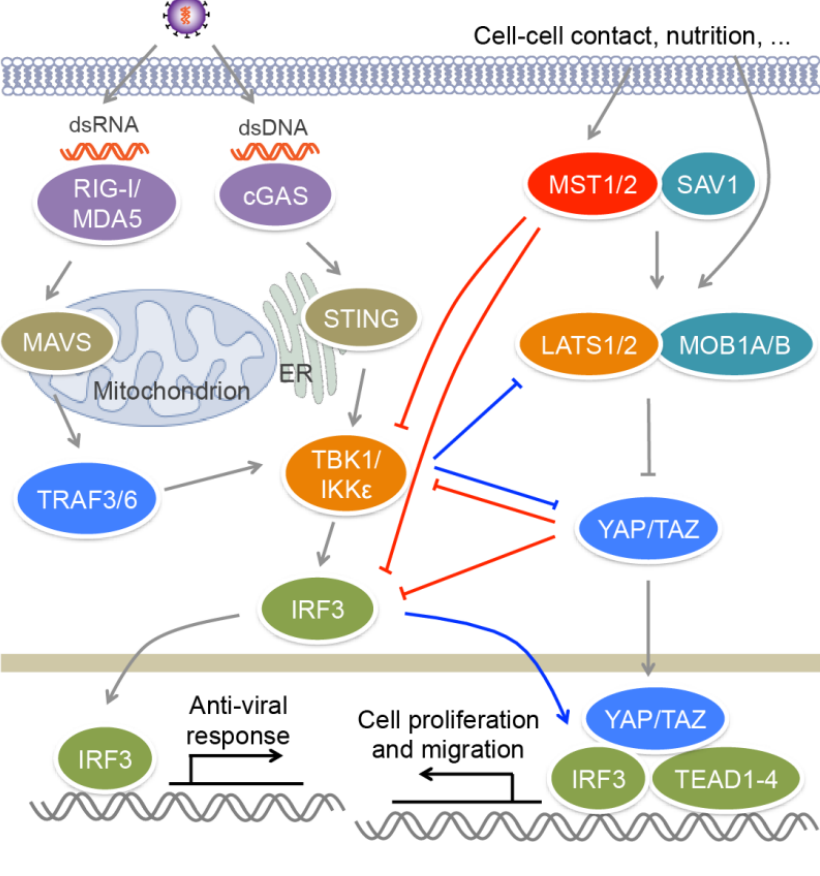
FIGURE 2: MST kinases and Hippo sig- naling regulate antiviral signaling. Upon viral infection, RIG-I/MDA5 and cGAS recognize viral dsRNA and dsDNA respec- tively, and activate TBK1/IKKε via adap- tors MAVS and TRIF, as well as E3 ligases TRAF3/6, leading to the activation of IRF3 and the production of IFNs. MST1 can phosphorylate and suppress the activation of IRF3, as well as TBK1, to impair antiviral response. The down- stream effectors YAP/TAZ of the Hippo pathway also negatively regulate antivi- ral signaling through inactivating TBK1 and IRF3. Viral infection induces the phosphorylation and degradation of YAP by IKKε, relieving its inhibitory role in antiviral immunity. IKKε can also induce the ubiquitination and degradation of LATS1/2 in glioblastoma multiforme cell lines, causing YAP activation. In addition, IRF3 can promote YAP−TEAD-driven gastric caner